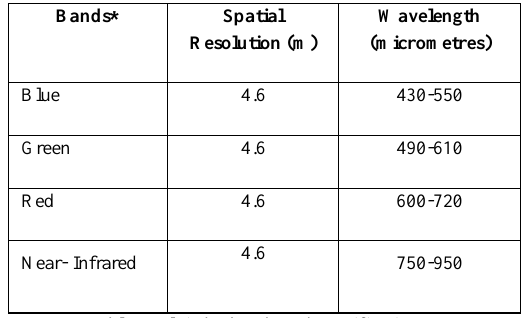
Table 1: Pleiades bands and specifications